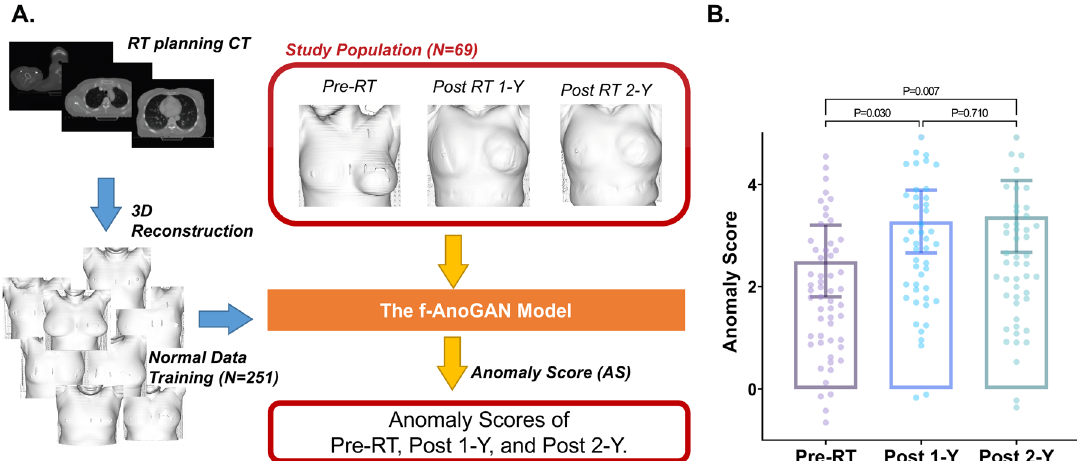
Fig. 1 Overview of generation of AS using developed f-AnoGAN model and pairwise comparison of AS. A Graphical representation of process for developing the f-AnoGAN model with normal image data from RT planning CT and generation of anomaly score by developed model in time-series manner. B Pairwise comparison of anomaly score among pre-RT, post 1-Y, and post 2-Y time points. P-value was estimated by pairwise paired T-test. The 95% con fi dence intervals are drawn as error bars at each point. 3D 3-dimensional, f-AnoGAN Fast